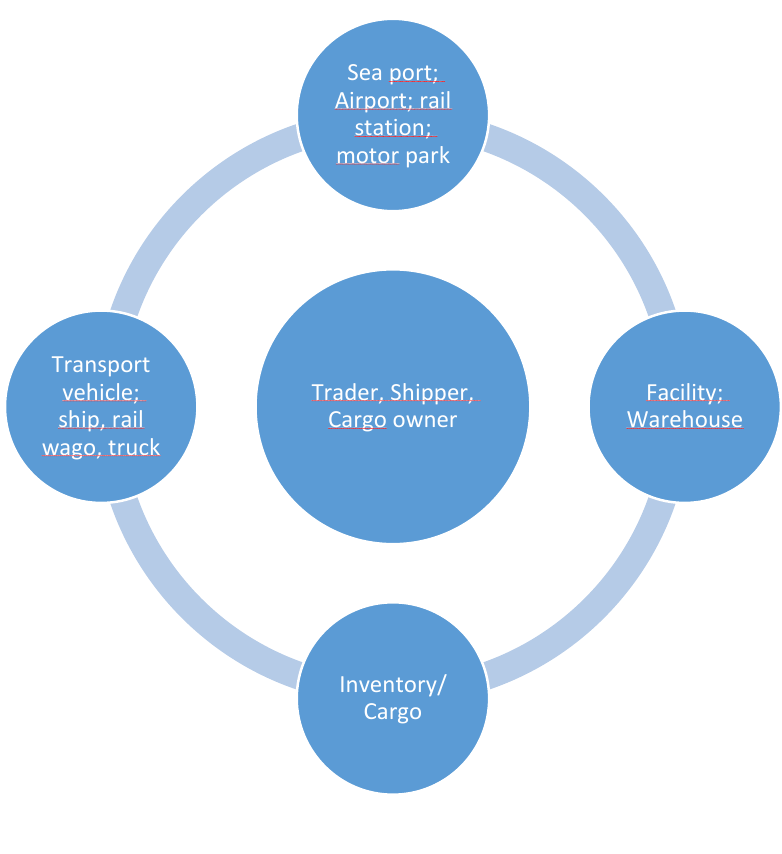
Figure 1: The scheme of